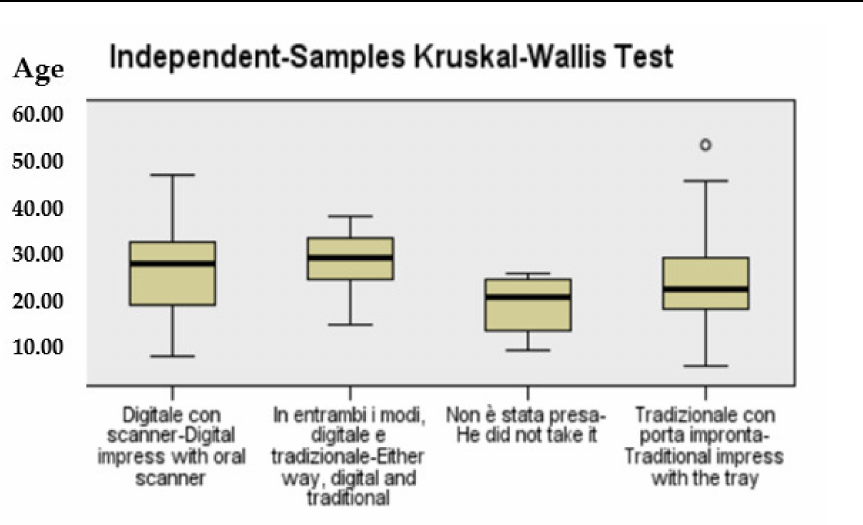
Figure 1. Kruskal-Wallis